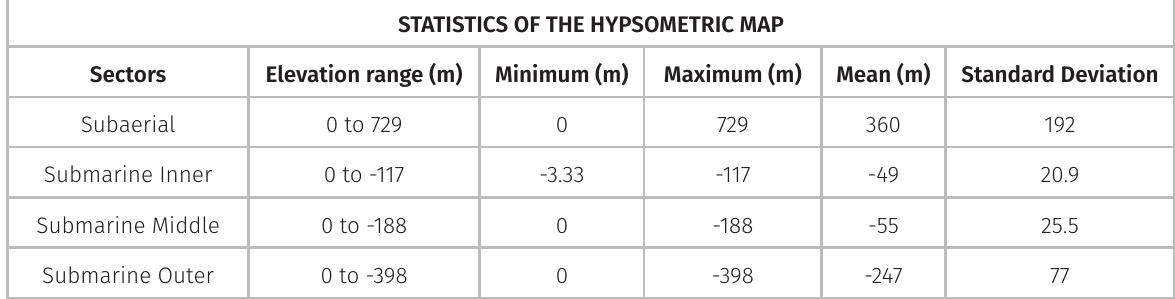
Table IV. Hypsometric and bathymetric statistics by MI